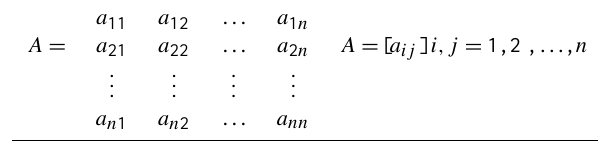
Table 2. Importance and priority degree according to the nine-point Saaty scale.